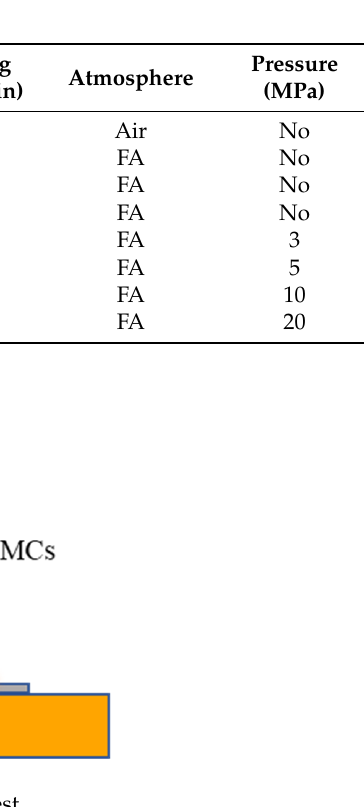
Table 1. Summary of heating processes.